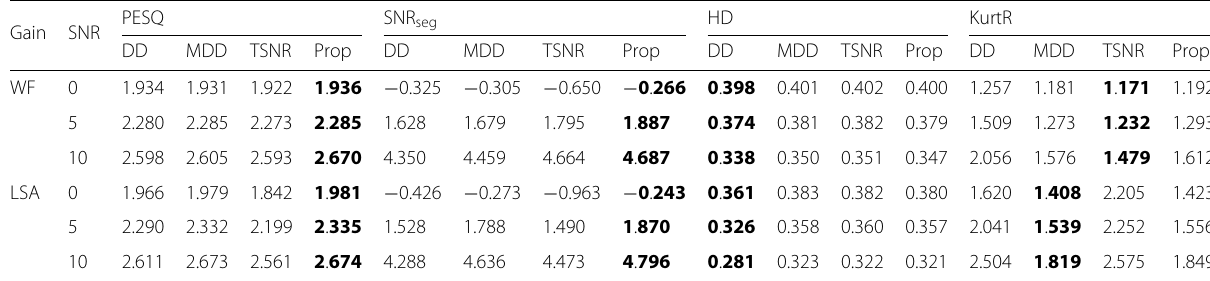
Table 7 Mean objective results for babble